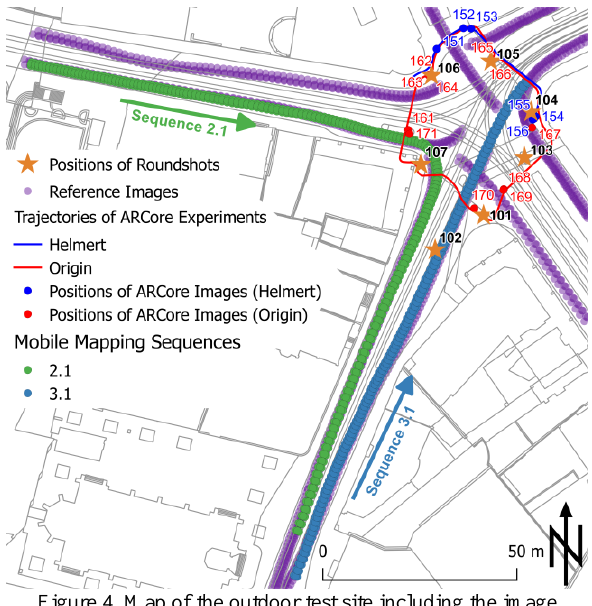
Figure 4. Map of the outdoor test site including the image positions (Source: Geodaten Kanton Basel-Stadt)